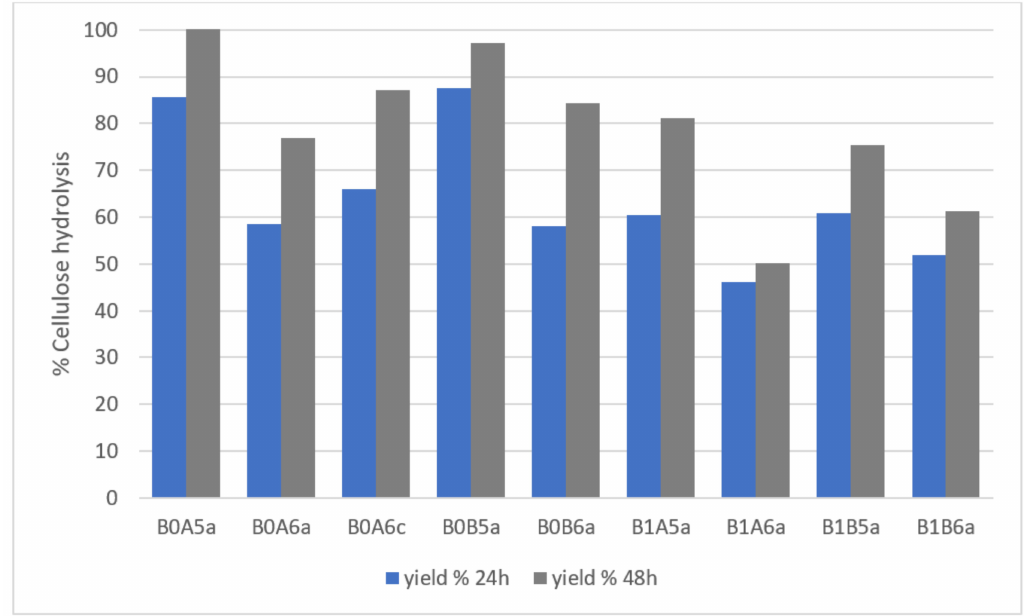
Figure 6. Enzymatic saccharification of the different pretreated biomasses. Representation of the codes: 0—pretreatment at 200 ◦ C; 1—pretreatment at 180 ◦ C; A—pretreatment time of 15 min; B—pretreatment of 30 min; 5—50% v / v ethanol content; 6—60% v / v ethanol content; a—no catalyst added; c—1% w / w biomass H 2 SO 4